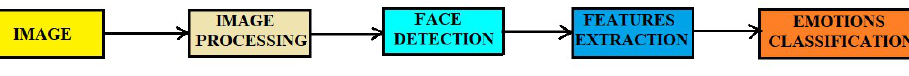
Figure 1. Flow chart of facial emotion